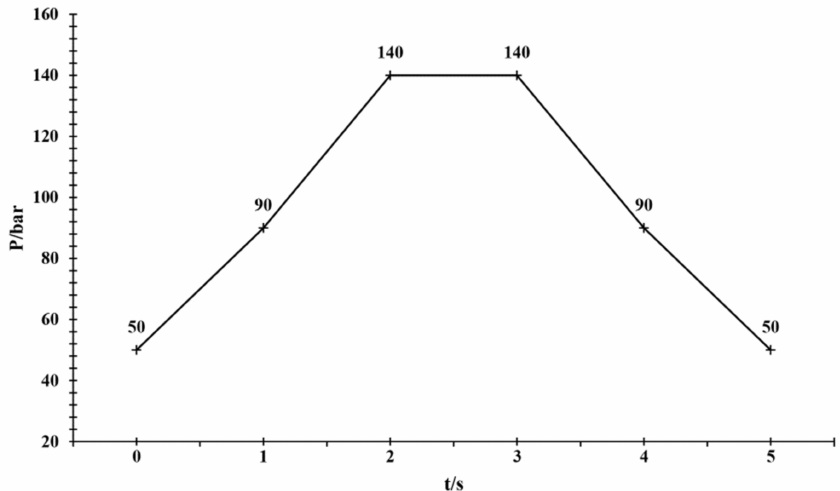
Figure 9. Pulse pressure curve for hydraulic pump